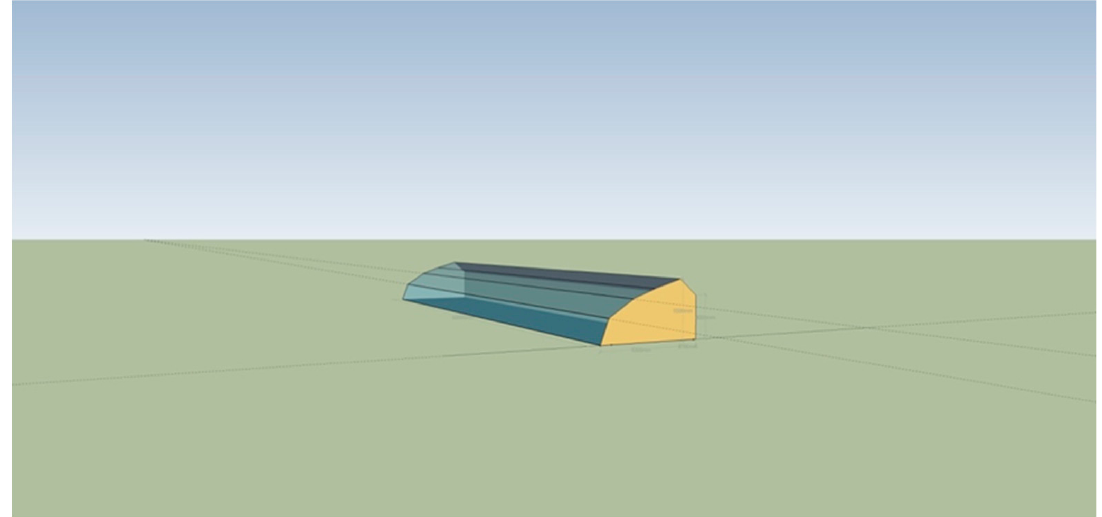
Figure 5. The geometry model of CSG in the simulation created by Skectchup.